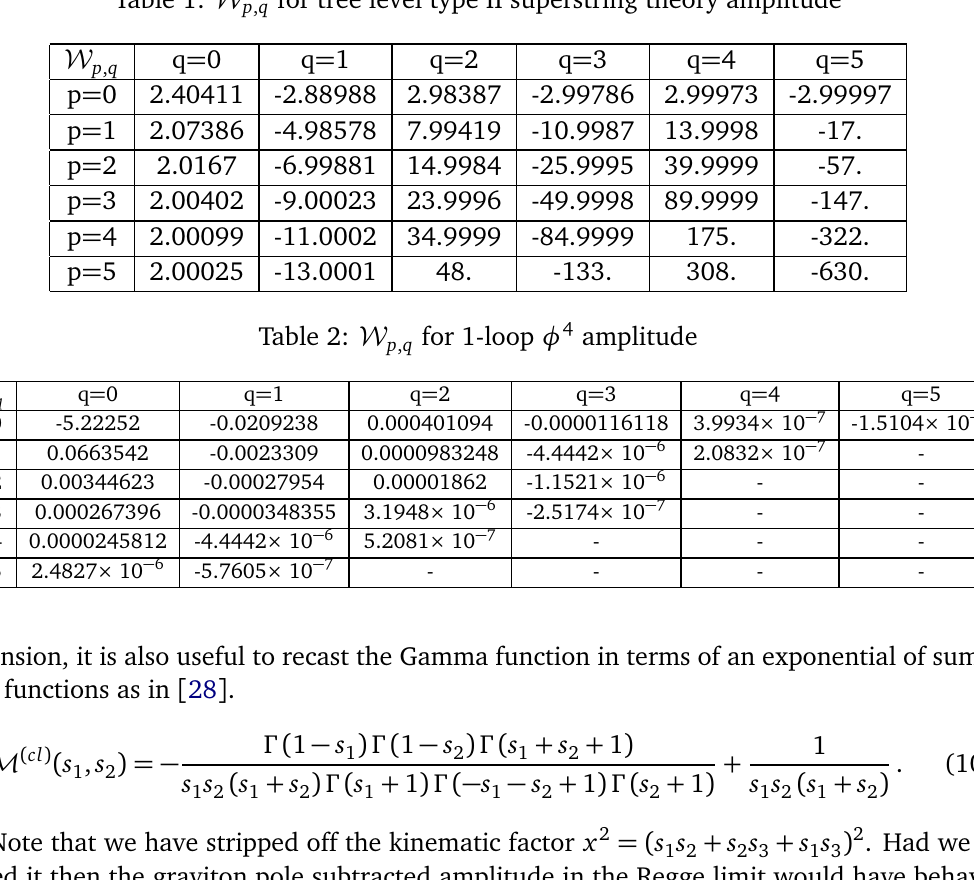
Table 1: W for tree level type II superstring theory amplitude p , q